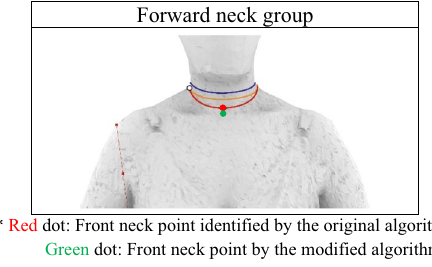
Fig. 4 The front neck point identified by the algorithm